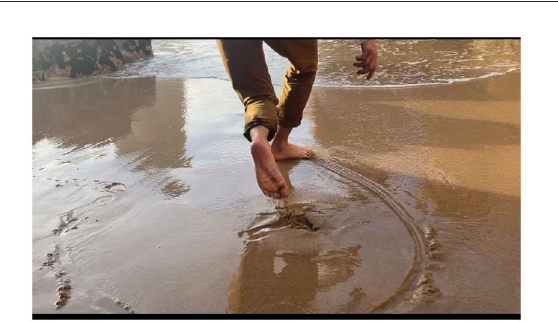
FIGURE5 Video still from dance film Between Foam and Origami by Michael O’Connor. A circle is seen drawn in the wet sand from the dancer’s foot before it quickly disappears in the tide. Camera: Lukas